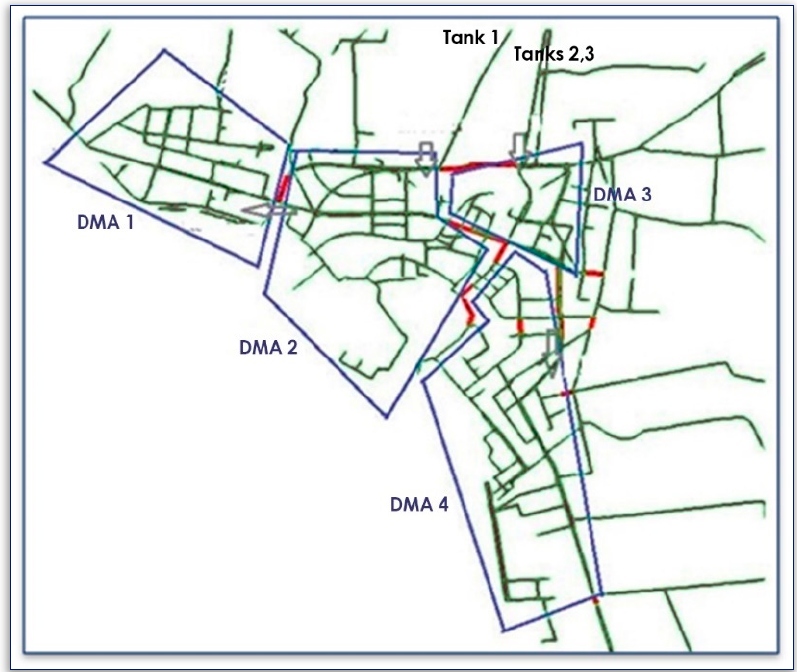
Figure 9. New formation of DMAs (Scenario B).